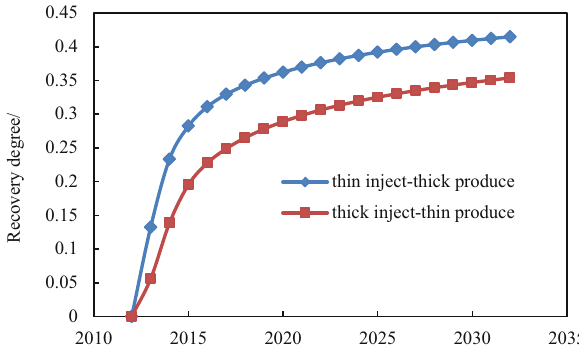
Fig. 5 Permeability saturation curve